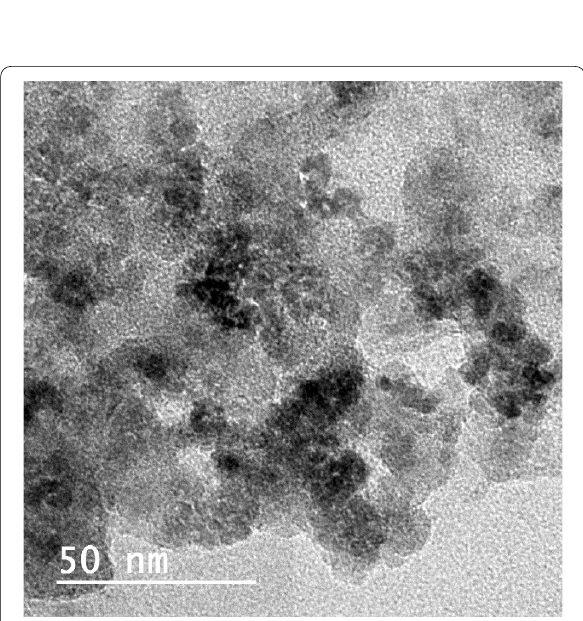
Fig. 4 MNPs’ dispersion within dextran matrix explained by TEM with magnification scale 200 nm